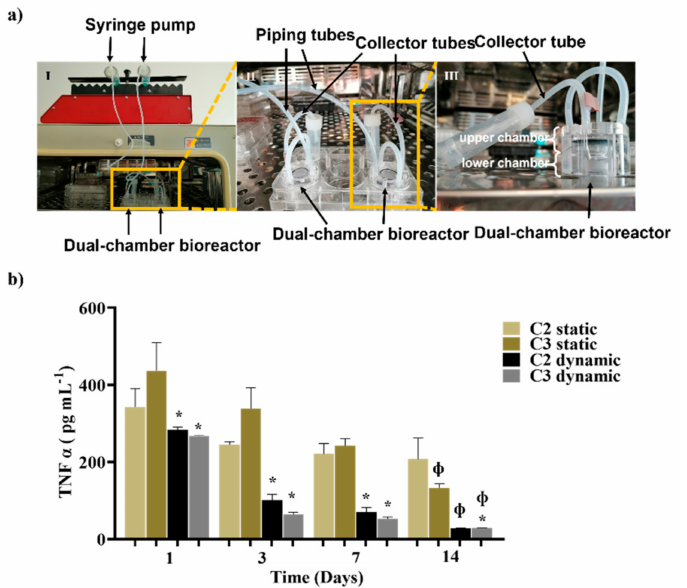
Figure 6. Evaluation of anti-TNF α Ab-CS/ PAMAM dendrimer NPs loaded-Ty-GG and Ty-GG/SF hydrogels effects under dynamic conditions. ( a ) Representative images of Dynamic culture of THP-1 cell-based inflammation in vitro model using a dual-chamber bioreactor showing the (I) dual-chamber bioreactor connected to a syringe pump; (II) higher amplification of the bioreactor inserted in a 6-well plate showing the piping tubes and collector tubes; and (III) enlarged image of the dual-chamber bioreactor where it is possible to see the upper and lower chamber. ( b ) Amount of TNF α present in the medium, in contact with C2 and C3 in static and dynamic conditions. Data shown as Mean ± SD. * indicates significant differences when comparing dynamic conditions with static conditions, Φ indicates significant differences when comparing with day